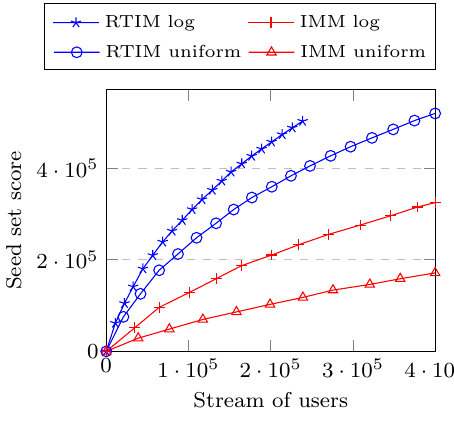
Fig. 7 LiveJournal ’s seed set